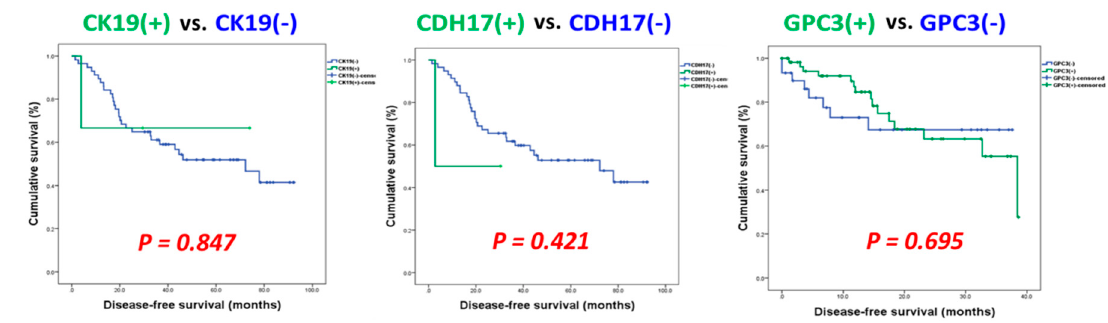
Figure 5. Kaplan–Meier disease-free survival (DFS) curves of N-HCC after hepatectomy Unlike HCC in general, CK19, CDH17, and GPC3 all were not significantly poor prognostic factors for DFS in N-HCC after hepatectomy ( P all > 0.05). DFS, disease-free survival; N-HCC, normal α -fetoprotein HCC; GPC3, glypican 3; CDH17, cadherin 17; CK19, cytokeratin 19.